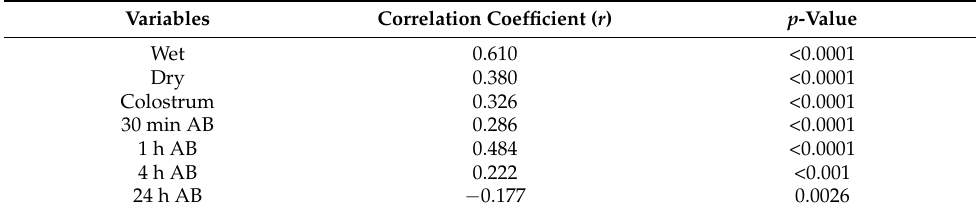
Table 10. Significant correlations between the weight of the dam and the superficial temperature at thoracic limb elbow (TLE) thermal window in newborn puppies at different times: wet (with amniotic fluid), dry (once the puppy was rubbered), colostrum (after colostrum intake and separated from mother’s teat), 30 min AB, 1 h AB, 4 h AB, and 24 h AB.